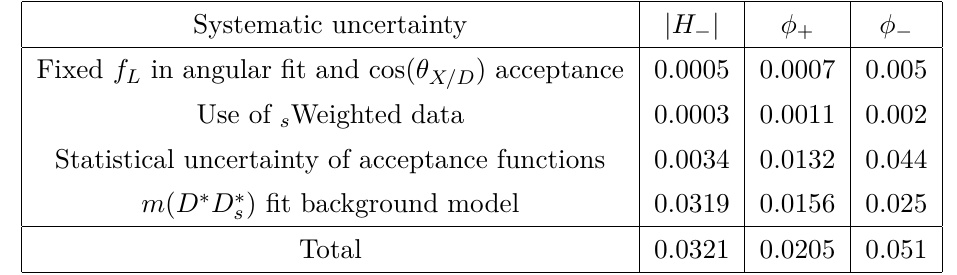
Table 2 . Systematic uncertainties on the helicity parameters measured in the unbinned angular